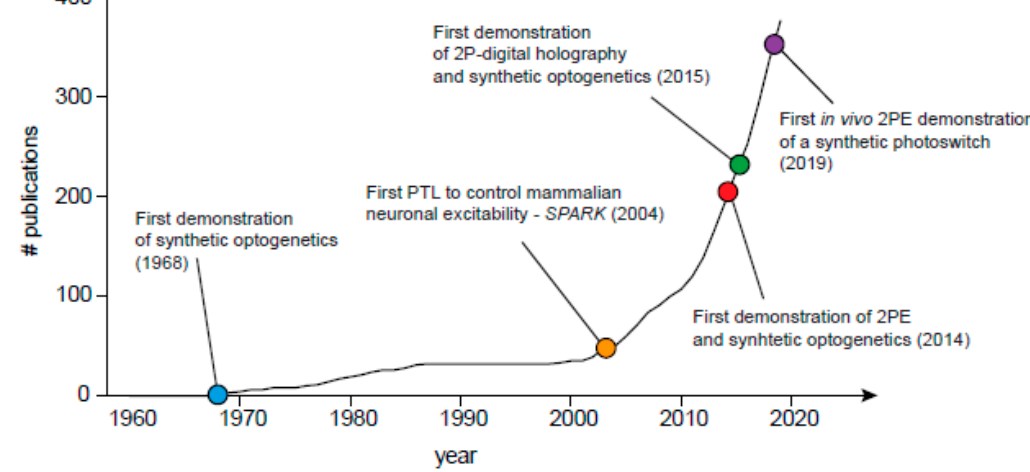
Figure 2. Graphical illustration of ‘synthetic optogenetics’ emerging in the scientific literature. Cumulative plot of number of publications across years was performed by searching for specific terms (chemical-optogenetics, photopharmacology, optopharmacology, synthetic optogenetics, optogenetic pharmacology, photoswitch, azobenzene and photo), as well as by searching for publications from recognized researchers in the field (e.g., Erlanger BF, Poolman B, Feringa B, Lester HA, Trauner D, Kramer RH, Isacoff EY, Woolley GA, Gorostiza P, Paoletti P, Ellis-Davies GCR, etc.). Search was continuously performed in various search engines, notably PubMed Central, Google Scholar, and bioRxiv. Last query was performed on November 2019.